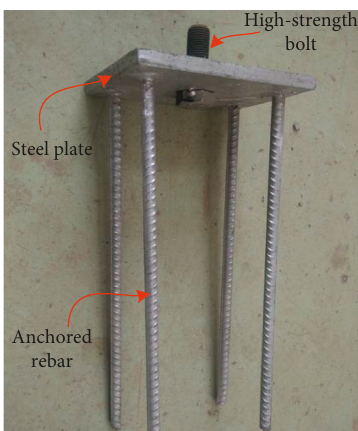
Figure 1: Details of a typical embedded dry